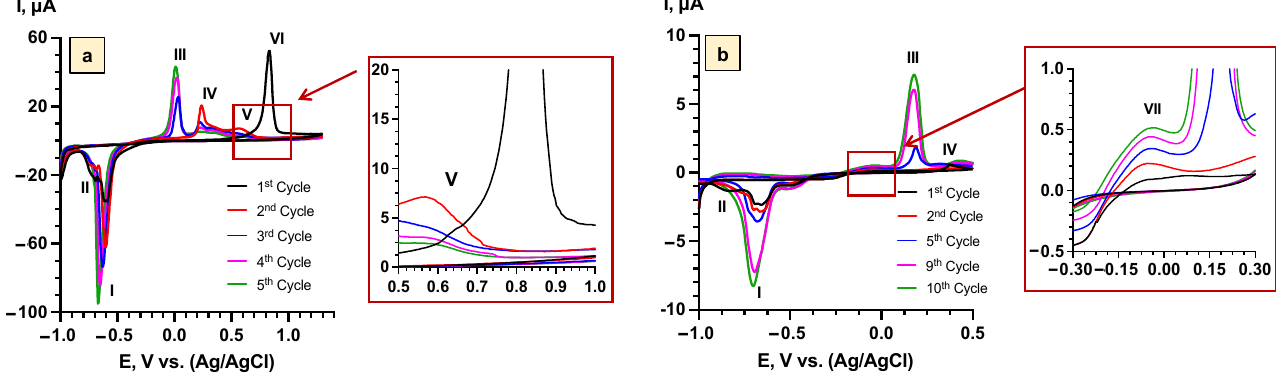
Cyclic voltammetry of Bi 2 Se 3 thin films in 5 M LiNO 3 at the scan rate of 0.25 mV s − 1 in the potential range ( − 1.0 ÷ 1.3 V vs. Ag/AgCl) showed two cathodic peaks (I, II) and four anodic peaks (III, IV, V, VI) (Figure 2a). The peaks I ( − 0.65 V vs. Ag/AgCl) and III (0.02 V vs. Ag/AgCl) represent the intercalation/deintercalation processes of Li + according to the reaction in Equation 1 [19]. The peaks II ( − 0.71 V vs. Ag/AgCl) and IV ( − 0.65 V vs. Ag/AgCl) are related to the substitution reaction of Bi 2 Se 3 and Li 2 Se (Equation (2)) [18,35]. Anodic peak V (0.61 V vs. Ag/AgCl) might describe a formation of NO 2- from NO 3- (Equa- tion (3)) [36]. NO 2- can be rapidly oxidized back to NO 3- due to the presence of dissolved O 2 in the electrolyte [37]. The peak VI (0.84 V vs. Ag/AgCl) appeared only in the first cycle and was attributed to the formation of the SEI layer, which, according to the literature on the other aqueous Li + systems (Mo 6 S 8 , carbon-coated TiO 2 , and carbon electrodes), is most Figure 1. ( a )—SEM image of Bi 2 Se 3 thin films on the glass substrate, ( b )—XRD pattern of Bi 2 Se 3 probably composed of Li 2 O and Li 2 CO 3 (Equations (4) and (5)) [24–26,38,39]. Figure 1. a —SEM image of Bi 2 Se 3 thin films on the glass substrate, b —XRD pattern of Bi 2 Se 3 powder powder obtained by scratching the as-grown thin film off the substrate. obtained by scratching the as-grown thin film off the substrate.